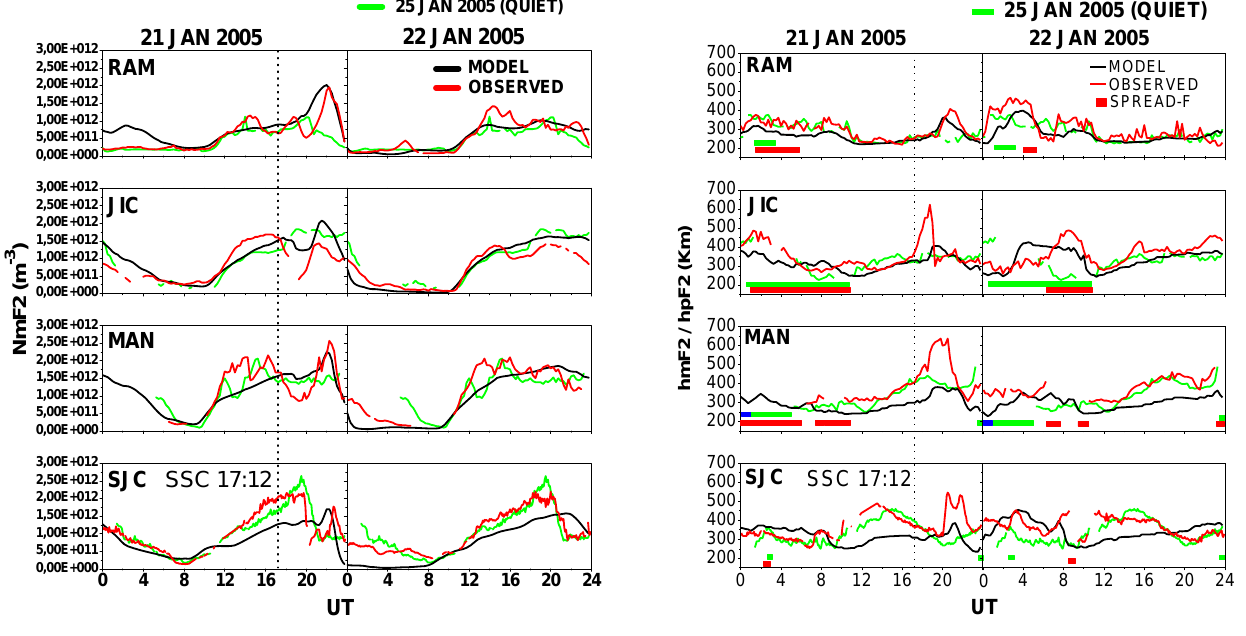
Figure 5 Fig. 5. Time variations of peak electron density of the ionospheric Fig. 6. Time variations of peak height of the ionospheric F- F-region ( Nm F2) (m − 3 ) observed on 21 and 22 January 2005 at region ( hp F2=virtual height at 0.834 fo F2) (km) observed on 21 Ramey (dip lat. 22.7 ◦ N), Jicamarca (dip lat. 0.4 ◦ N), Manaus (dip and 22 January 2005 at Manaus (dip lat. 5.8 ◦ N) and S. J. Cam- lat. 5.8 ◦ N), and S. J. Campos (dip lat. 18.1 ◦ S) (red lines) along pos (dip lat. 18.1 ◦ S) (red lines). In addition, time variations of with the TIME-GCM results (black lines). Also, Nm F2 observa- peak height of the ionospheric F-region hm F2 (km) observed on 21 tions at the four stations on a quiet day (25 January 2005) (green and 22 January 2005 at Ramey (dip lat. 22.7 ◦ N) and Jicamarca (dip lines) are shown. The hatched vertical line on 21 January indicates lat. 0.4 ◦ N) are shown (red lines). The TIME-GCM hm F2 results for the time (17:12UT) of storm sudden commencement (SSC). different stations are shown (black lines). Also, hp F2/ hm F2 obser- vations at the four stations on a quiet day (25 January 2005) (green lines) are shown. The hatched vertical line on 21 January indicates the time (17:12UT) of storm sudden commencement